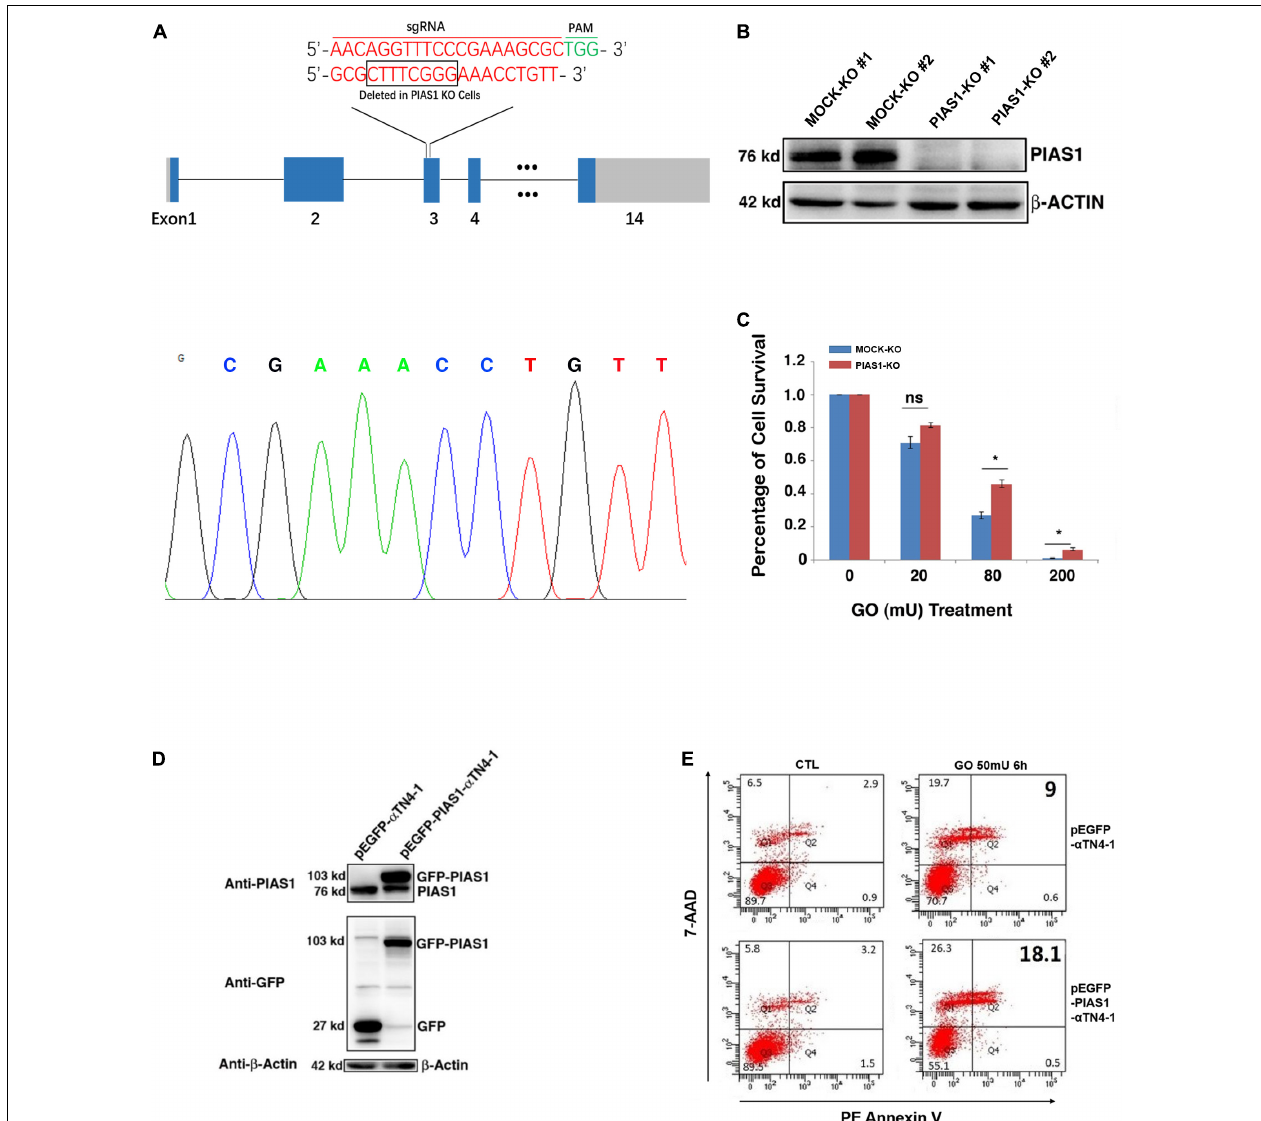
FIGURE 2 | PIAS1 promotes oxidative stress-induced apoptosis of lens epithelial cells. (A) Schematic diagram of the strategy for generating the PIAS1 knockout cells by CRISPR/Cas9 gene editing technology. Two sets of sgRNAs were used to generate the knockout cell line (top). Eight nucleotides were deleted in exon 3 and the deletion was verified by DNA sequencing (bottom). The mapping sequence of the genomic DNA with deletion in PIAS1 knockout cells was shown. PAM, protospacer adjacent motif. (B) Western blot analysis of the expression levels of PIAS1 in α TN4-1 negative-control vector (MOCK-KO) and PIAS1 knockout (PIAS1-KO) cells. Note that expression of PIAS1 was not detectable in PIAS1 knockout cells. The β -actin was used as a loading control. (C) Apoptosis rate in MOCK-KO ad PIAS1-KO cells under treatment of 20, 80, and 200 mU GO for 3 h as measured with CellTiter-Glo R (cid:13) Luminescent Cell Viability Assay analysis. (D) Western blot analysis of endogenous and exogenous expression of PIAS1 in pEGFP- α TN4-1 and pEGFP-PIAS1- α TN4-1 cells detected with anti-GFP and anti-PIAS1 antibodies. The β -actin was used as a loading control. (E) Apoptosis rate in pEGFP- α TN4-1 and pEGFP-PIAS1- α TN4-1 cells under treatment of 50 mU GO for 6 h measured by flow cytometry. Cells with the indicated treatment were stained with phycoerythrin annexin V (PE) and 7-amino-actinomycin (7-ADD) before flow cytometry analysis. Numbers indicate percentage of apoptotic and non-apoptotic cells in each gate. All experiments were repeated three times. Error bar represents standard deviation, N = 3. * p < 0.05; ns, statistically not significant.